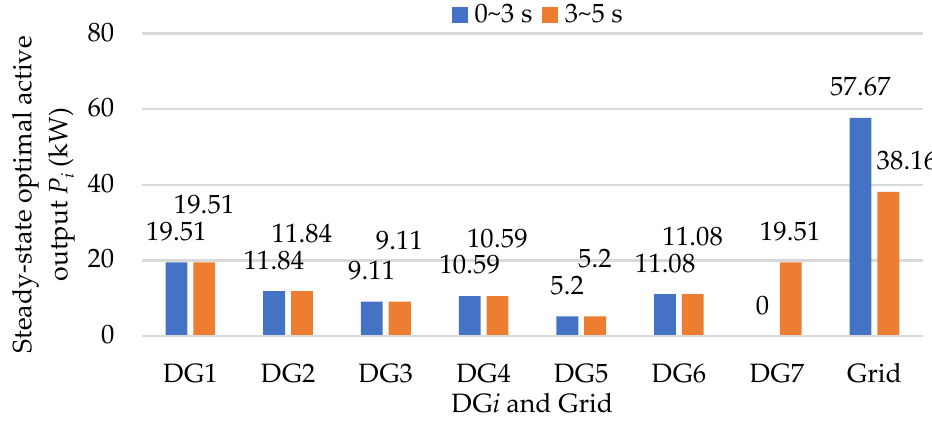
Figure 25. Comparison of steady-state optimal active output of each DG before and after the joining of DG7.